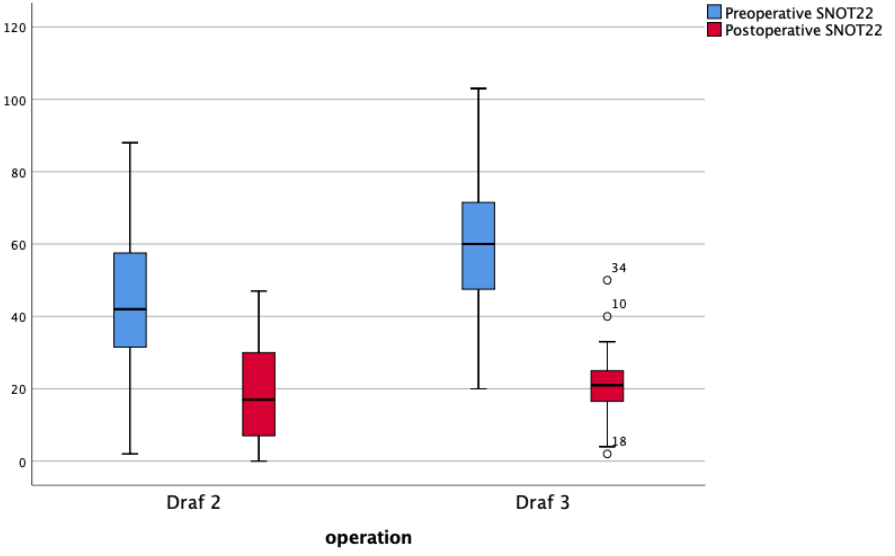
Figure 1. Preoperative and postoperative median SNOT 22 (Sino Nasal Outcome Test-22) scores by operation.